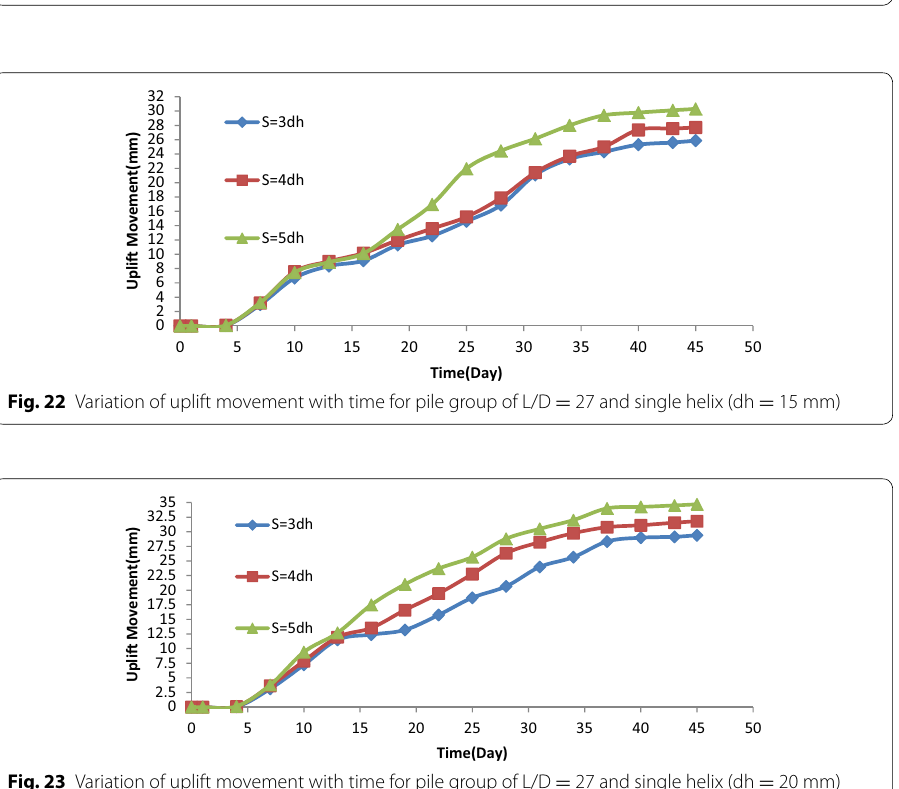
27 and single helix (dh =